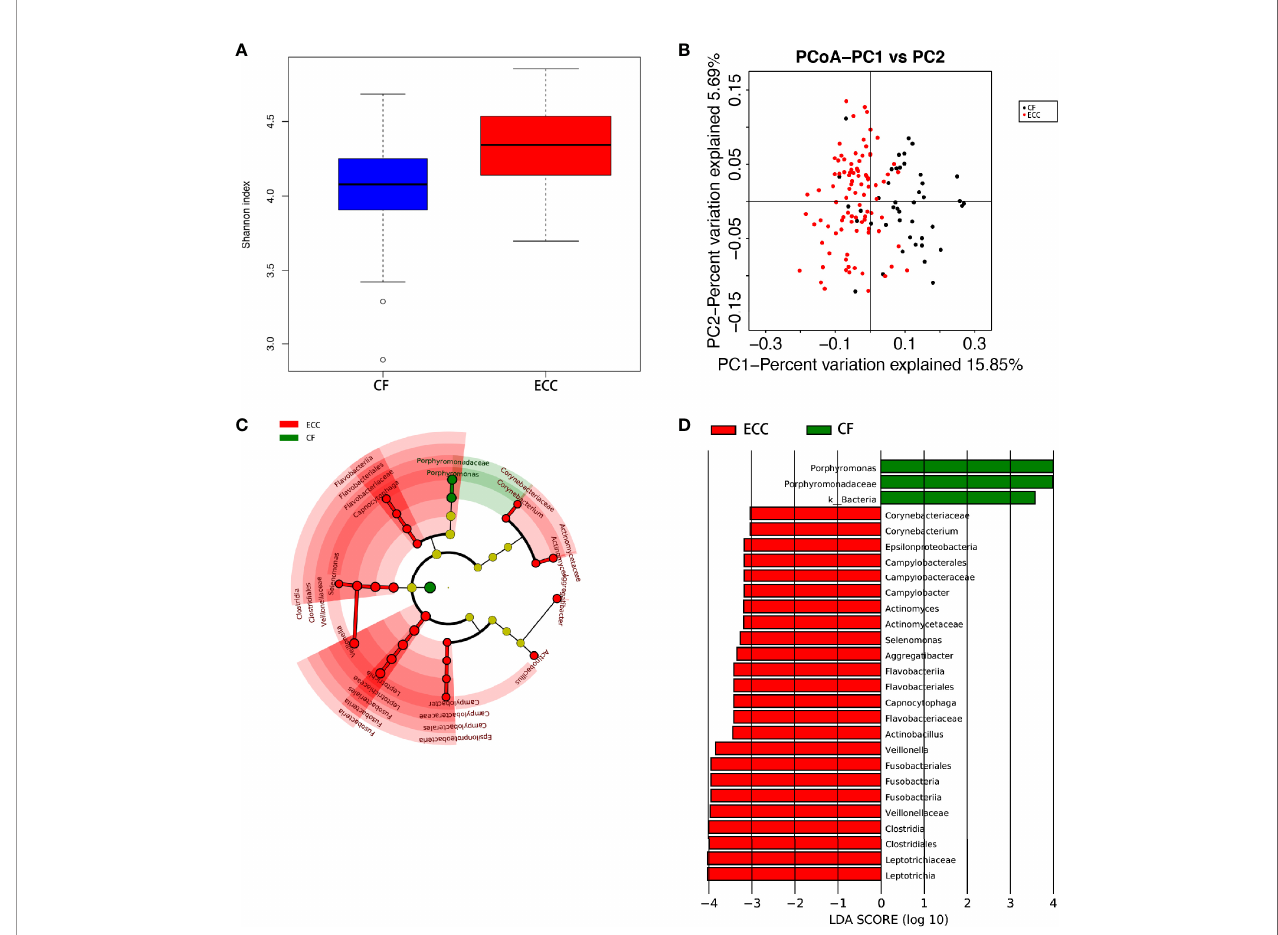
FIGURE 2 | (A) Alpha diversity measurements using a Shannon index analysis indicated that ECC samples had higher genus diversity than CF samples. p.shannon ≤ 0.001. (B) Unweighted UnifracPCoA analysis. For each sample, the fi rst two principal coordinates (PCo1 and PCo2) from the principal coordinate analysis of weighted UniFrac are plotted. The variance as calculated by PCoA is indicated in parentheses on the axes. ECC (black dots): saliva samples from ECC subjects. CF (red dots): saliva samples from CF subjects. (C) Cladogram of taxonomic biomarkers between the ECC and CF groups as identi fi ed by LEfSe. Green and red indicate data from the CF and ECC groups, respectively. (D) LDA score bar plot of taxonomic biomarkers between the ECC and CF groups as identi fi ed by LEfSe. Green represents the CF group. Genus of bacteria with high content. Red represents the ECC group. Genus of bacteria with high